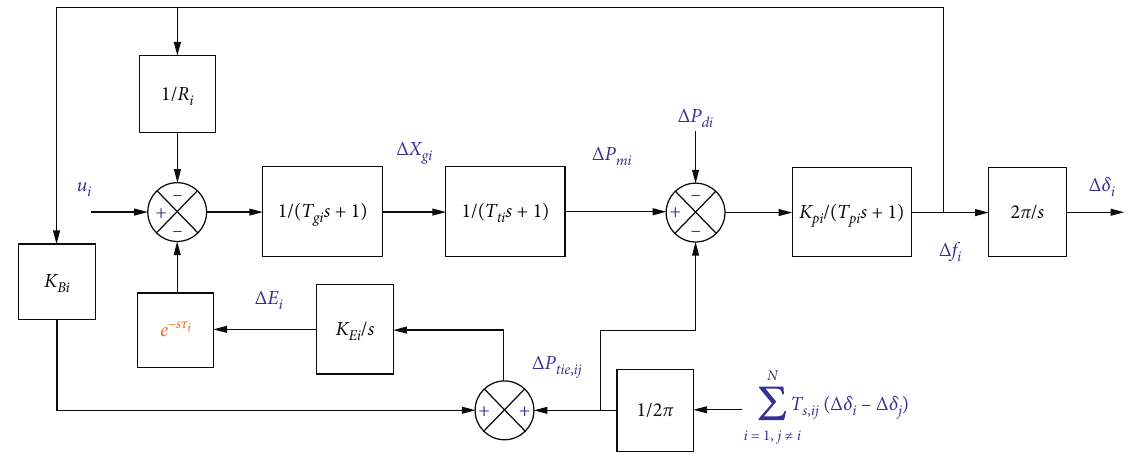
Figure 1: The structure of i th area of the